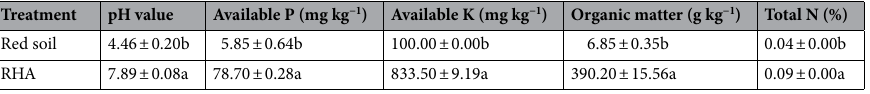
Table 1. Chemical properties of rice husk ash (RHA) and red soil . Values followed by different letters within the same column are statistically different at P ≤ 0.05 level. Values are presented as means ± SD.The same as below.